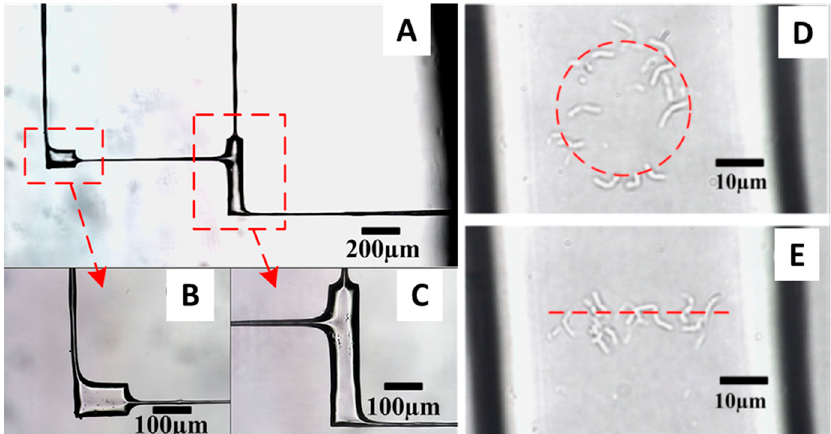
Figure 3. ( A ) Microfluidic device made of two micropools and four microchannels. ( B , C ) Magnified views of the micropools. ( D , E ) Circular and linear distributions of B. subtilis manipulated inside the micropools with a fs laser trap. Adapted with permission from [73]. Copyright 2014 Elsevier.